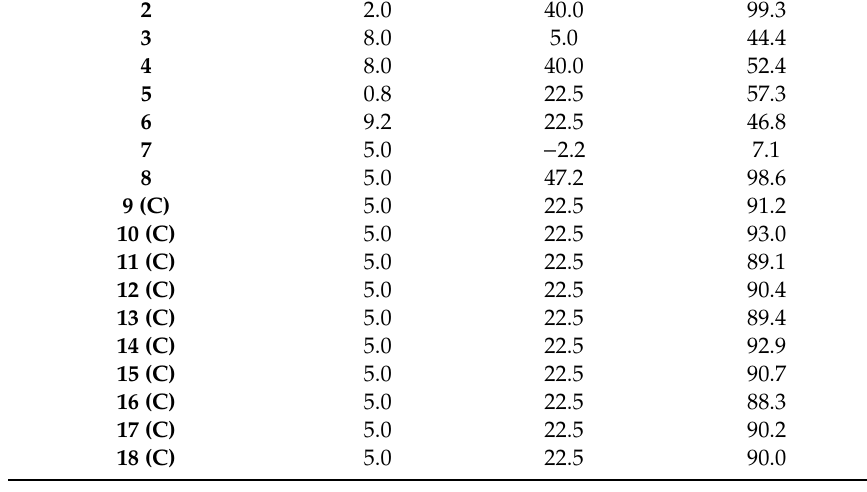
Table 2. Central composite design matrix and %removal efficiency as an analytical response.